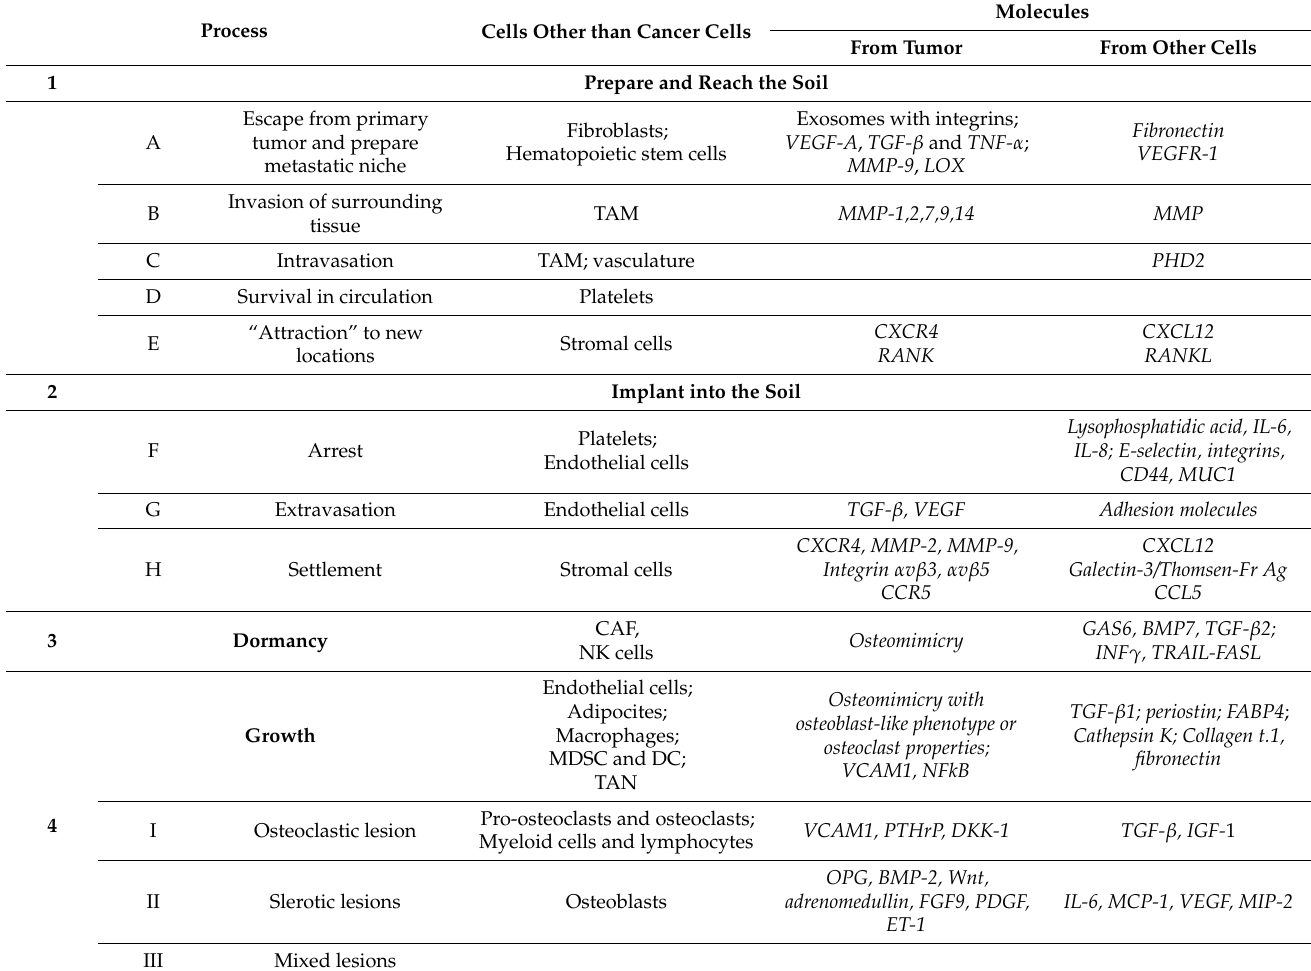
Figure 1. Steps of metastatic cascade. Table 1. The metastatic cascade’s major steps.